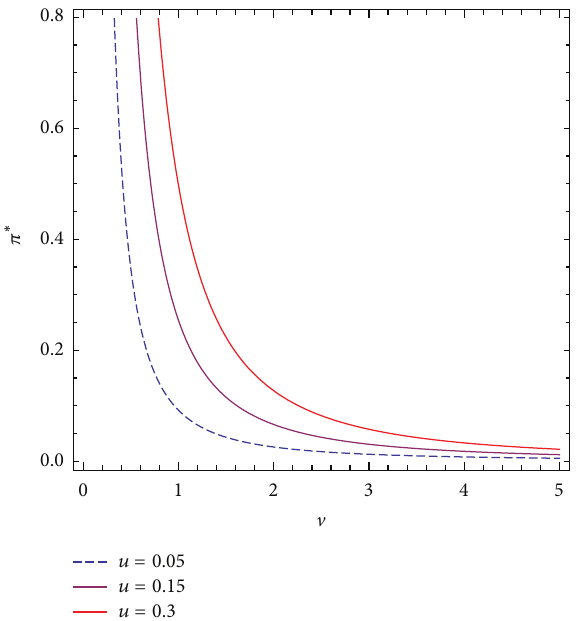
Figure 8: The optimal investment strategy varies with respect to V at different 𝑢